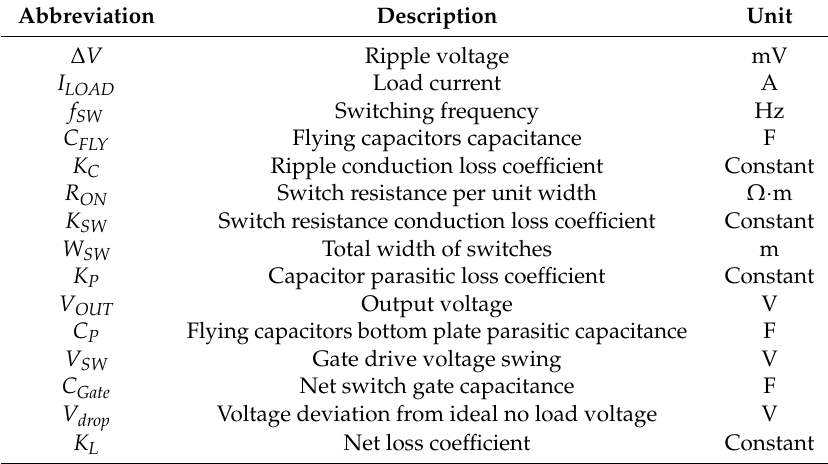
Table 1. Parameters